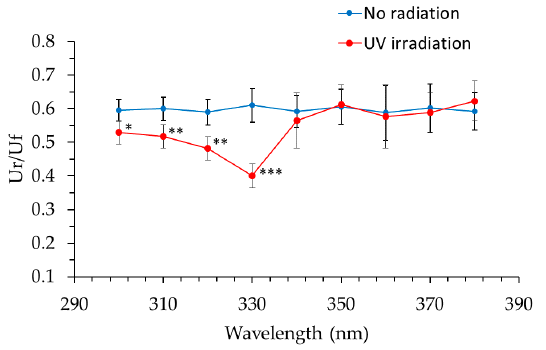
Figure 7. Dynamic spectrum of the Ur/Uf value of collagen gels irradiated with UV rays. n = 5, Mean ± S.D., * p < 0.05 vs. 0 J/cm 2 , ** p < 0.01 vs. 0 J/cm 2 , *** p < 0.001 vs. 0 J/cm 2 .